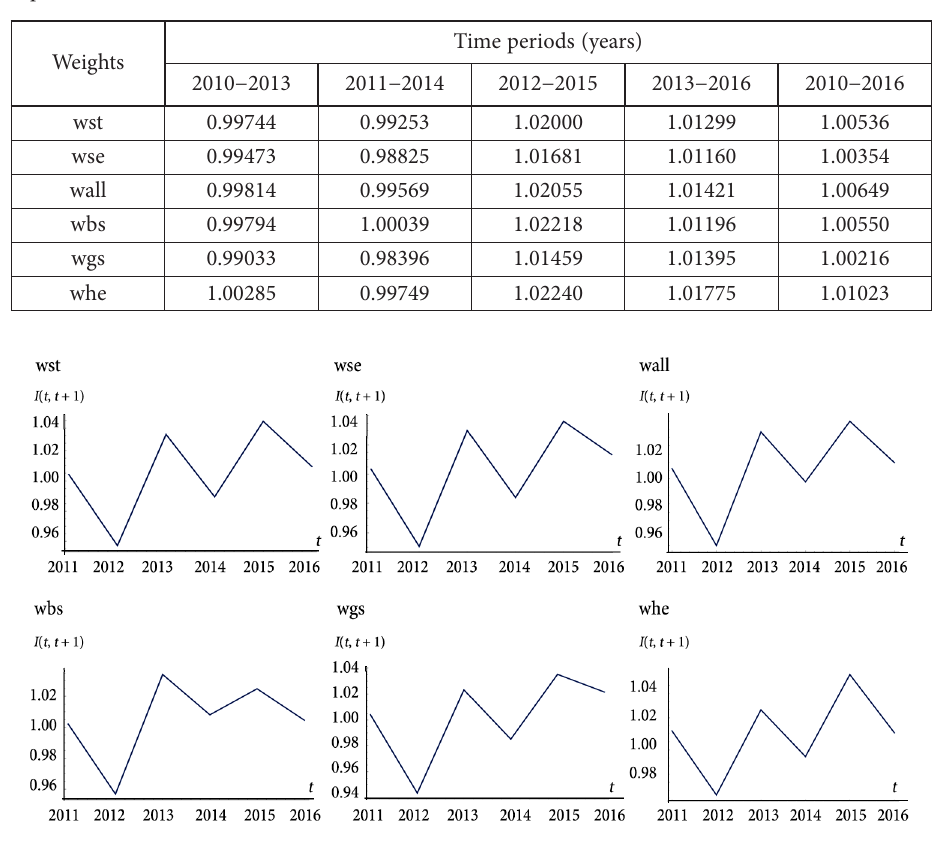
Figure 3. The one-year innovativeness changes depending on the system of weights and calculated for the EU-13 (source: own elaboration based on the data of the European Statistical Office – Eurostat and European Commission, 2018. European Innovation Scoreboard